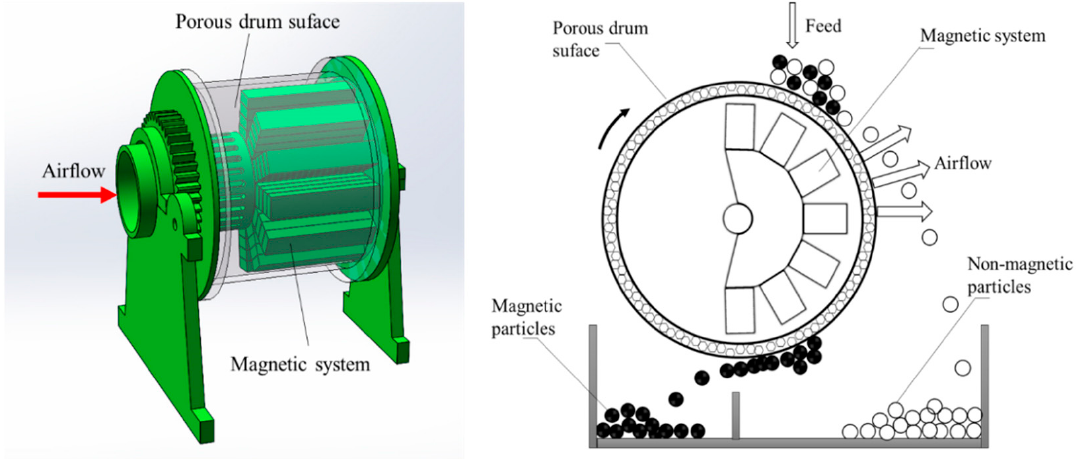
Figure 1. Structure and working principle of Aerodynamic Drum Magnetic Separator (ADMS).